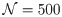
Rose plots of the angle of motion for stochastic switching and vector integration cases.Distribution of angles of motion of cells in colonies exposed to a pair of light sources placed at different positions relative to it. The probabilities are represented by the histogram of the angles made by the movement of a cell in a single time step. The light sources are placed at angles 30° (a,d), 60° (b,e) and 90° (c,f) North/South of East as shown in the respective figures. The intensity (and related pphoto) is constant across all figures and is also assumed not to vary significantly across the size of the colony. In (a-c) at each step cells stochastically bias their motion in the direction of one of the light sources. In (d-f) at each step cells bias their motion towards the vector sum of the light sources. In all cases, the intensity of color of the bars of the rose plots are related to their magnitude. In each subfigure, the insets show the final colony morphology. Each colony contains N=500 cells, and the model was simulated for 4 × 104 time steps for the case p1 = p2 = 0.05.